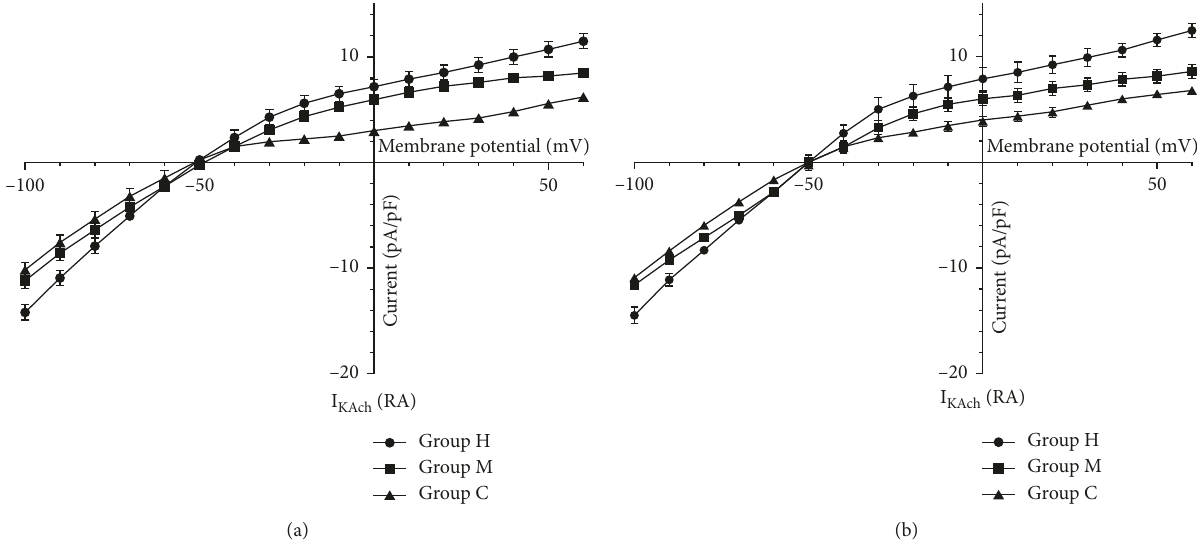
Figure 5: Effects of different-intensity training on atrial tissue IK Ach current-voltage in rabbits. Clamping voltage: 100mV: (a) RA; (b)